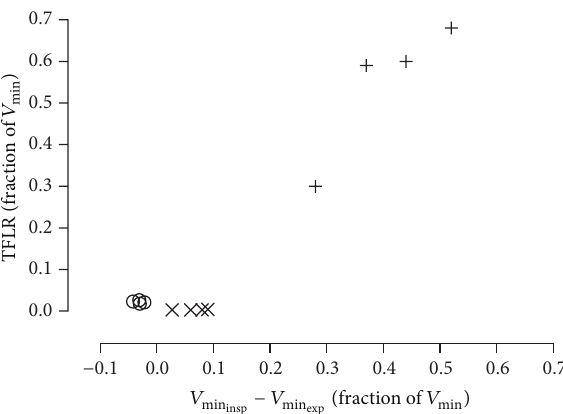
Figure 6: Loss of delivered minute volume of Portex Blue Line Ultra (+), TRACOE twist ( × ), or R¨usch Traceofix ( I ) tracheostomy tubes plotted against transfenestration leakage rate measured at PEEP settings of 3, 6, 9, and 12 mbar. Measurements were obtained in volume-controlled ventilation (ventilator rate: 15 breaths ⋅ min −1 , tidal volume: 450 mL) at 37 ± 1 ∘ C. Lung simulator compliance: : inspi- 20 mL ⋅ mbar −1 . TFLR: transfenestration leakage rate; 𝑉 min insp ratory minute ventilation; 𝑉 min : expiratory minute exp